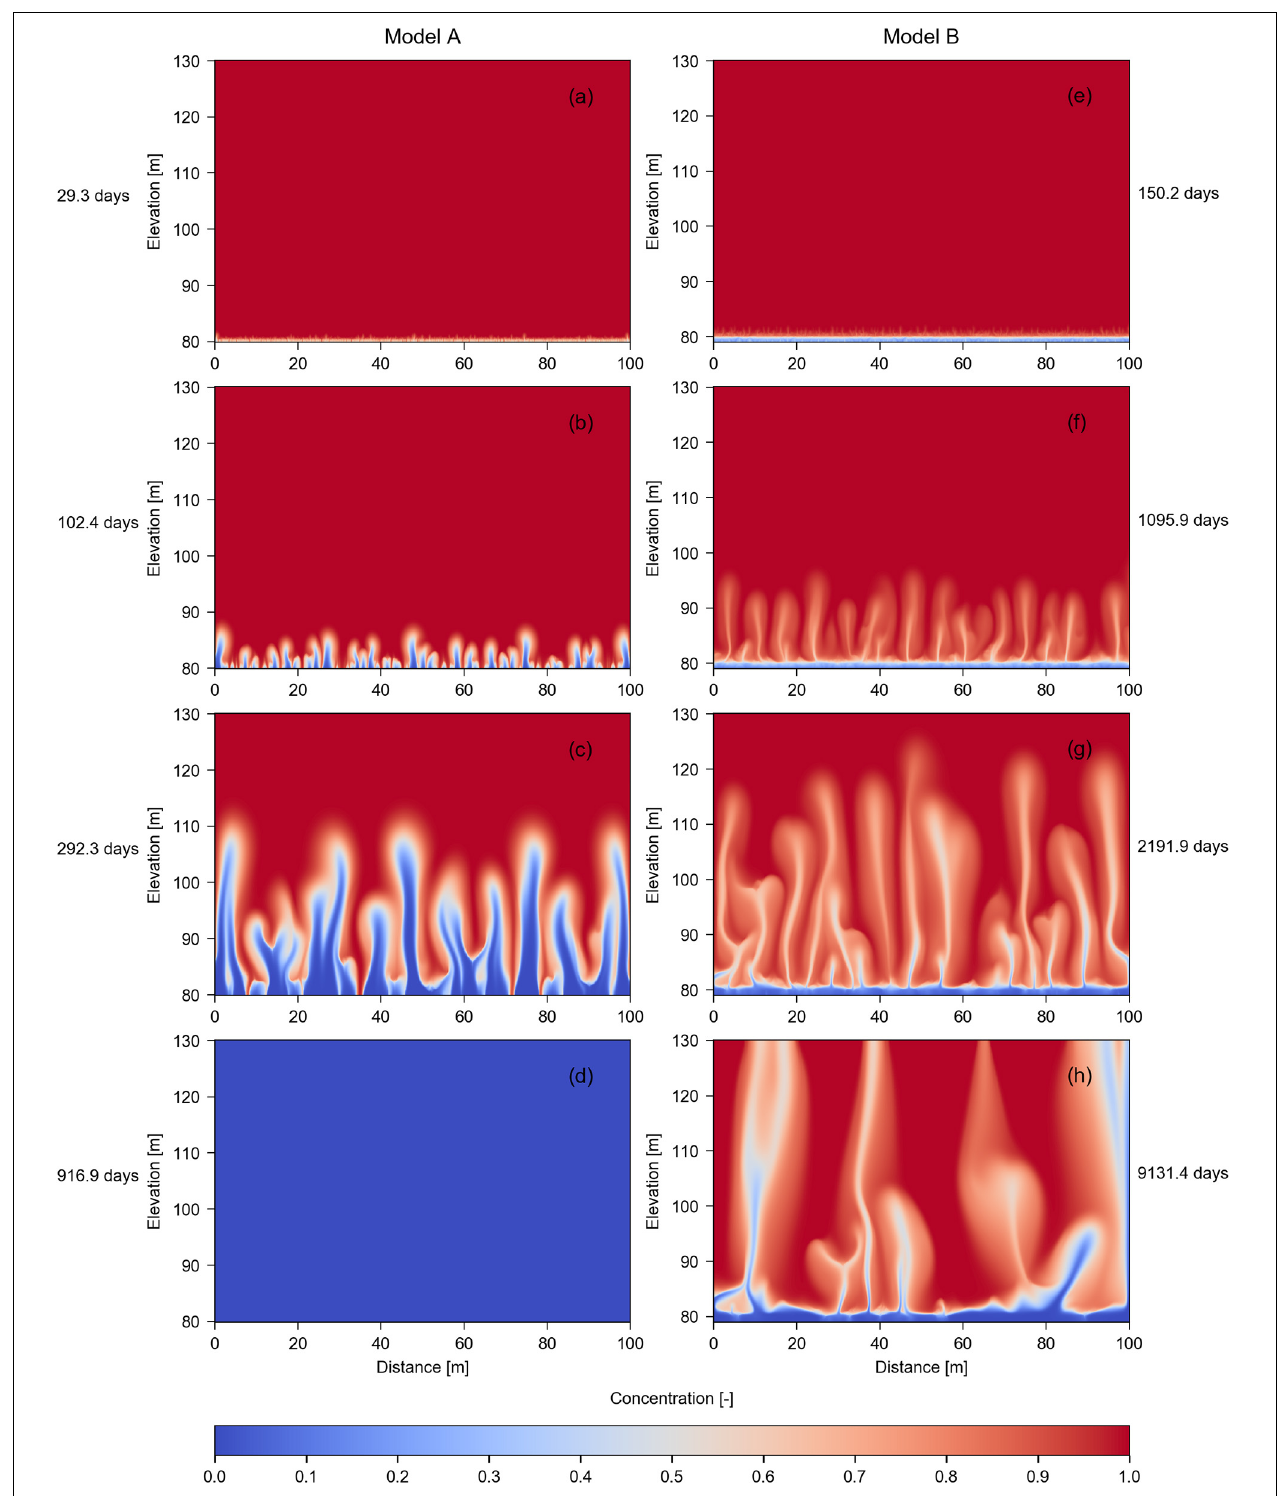
FIGURE 5 | Salinity distribution in seafloor sediments obtained from simulations of Case 2 (i.e., α L = 1 m; α T = 0.1 m) of Model A (left column) and Model B (right column) at various simulation times. Concentration values represent the relative seawater concentration, where 0 and 1 are freshwater and seawater, respectively. The bottom left subplot depicts steady-state results, while the bottom right subplot shows a quasi-steady state salinity distribution. (a) 29.3 days; (b) 102.4 days; (c) 292.3 days; (d) 916.9 days; (e) 150.2 days; (f) 1095.9 days; (g) 2191.9 days; (h) 9131.4 days.